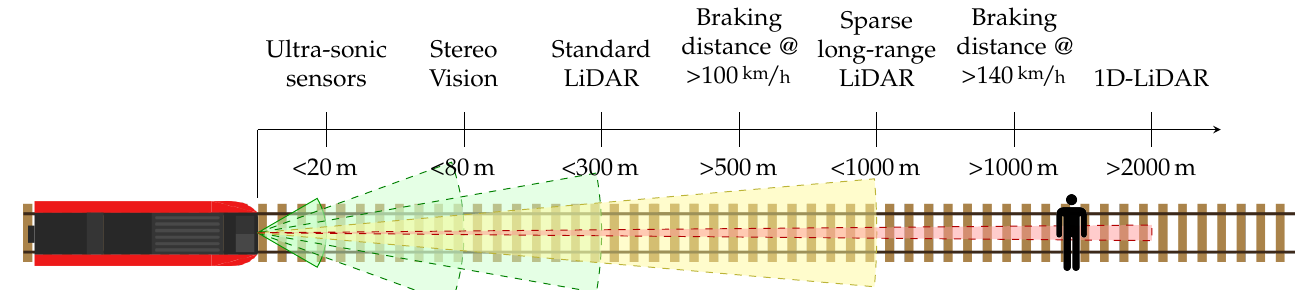
Figure 1. Sensing range of a variety of sensors commonly used for obstacle detection and autonomous vehicles. Furthermore, braking distances at various velocities are shown. The Field of View (FoV) of the individual sensors is highlighted through their color, ranging from super wide FoVs (green) to single point measurements